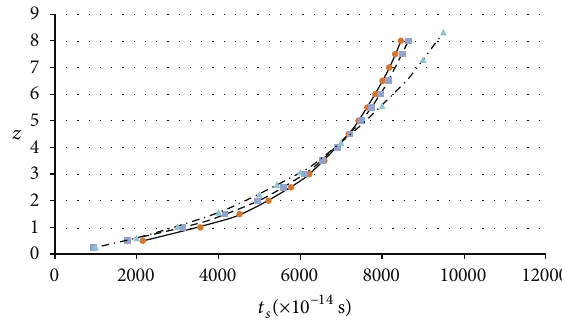
Figure 3: Triangles: gold-set data; solid line: 𝐻 0 = 77.25 kms −1 = Mpc −1 ; dashed line: 𝐻 0 = 66 kms −1 Mpc −1 . 0